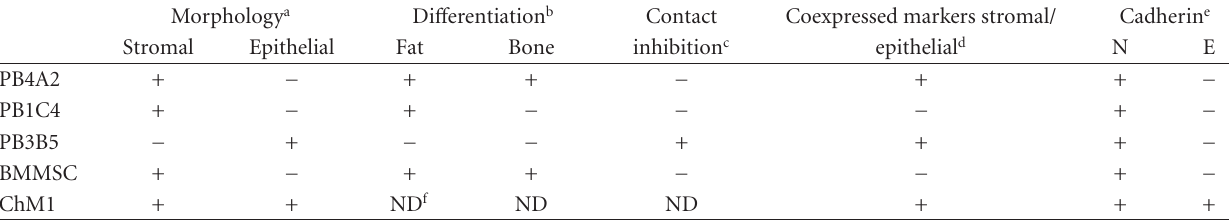
Table 3: Similarities and di ff erences among cell populations.